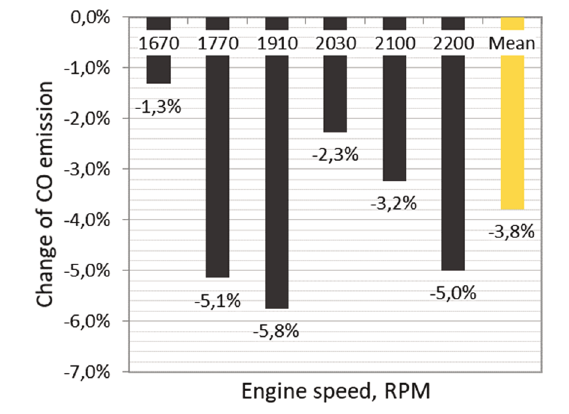
Fig. 10. Differences in CO emission power between engines with constant and variable ignition advance angle